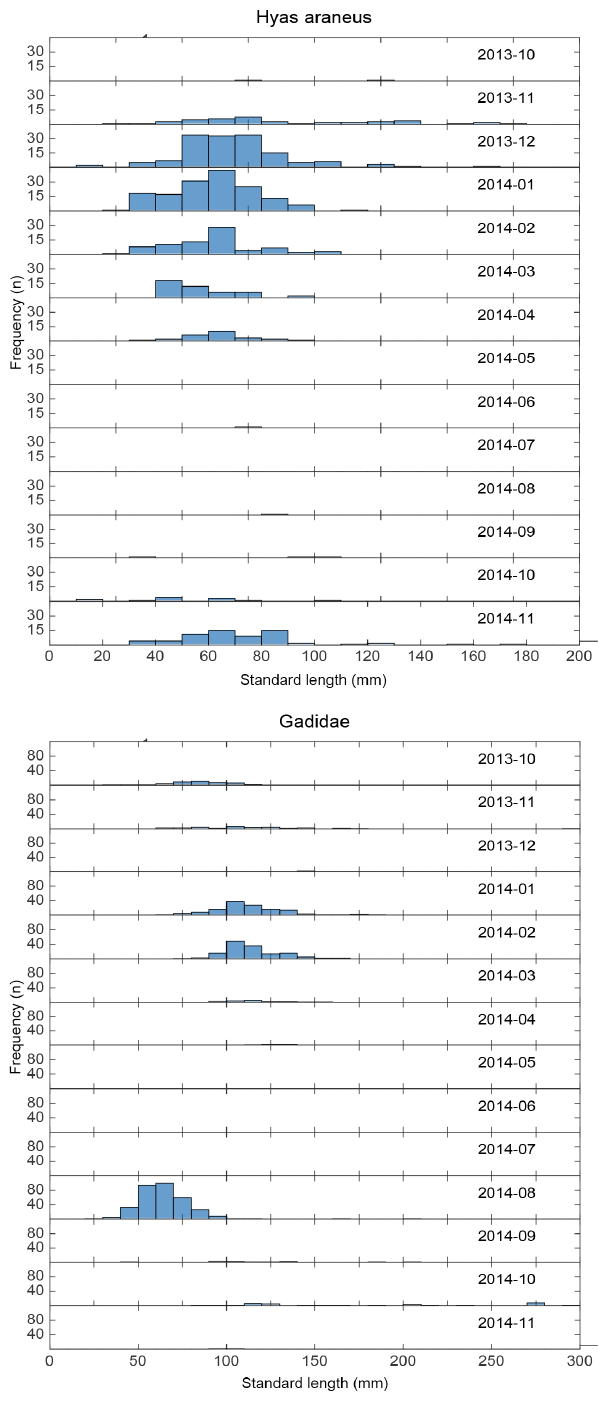
Figure 9. Length–frequency distributions of selected species or groups (see panels) over the seasonal